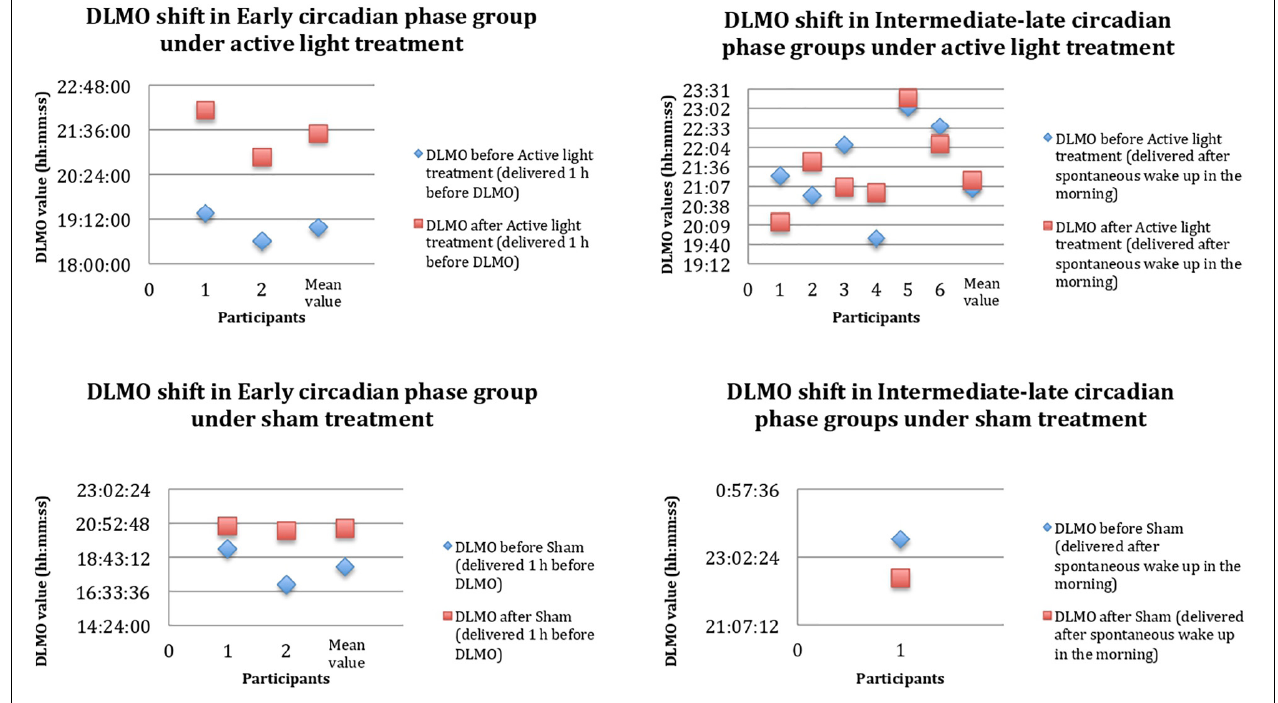
FIGURE 3 | DLMO shift before (PRE, blue rhombuses) and after (POST, red squares) 4-week Luminette protocol. The x -axis shows any single patient in progressive numbers, and the y -axis shows the hours of the day. DLMO, dim light melatonin onset. After a single-blind 4-week tailored light therapy, patients with AD presented a circadian phase shift toward a later chronotype (mean values). These data are probably the result of a more consistent circadian phase shift in the Early Circadian Phase patients (ECPpts) compared to Late Circadian Phase patients